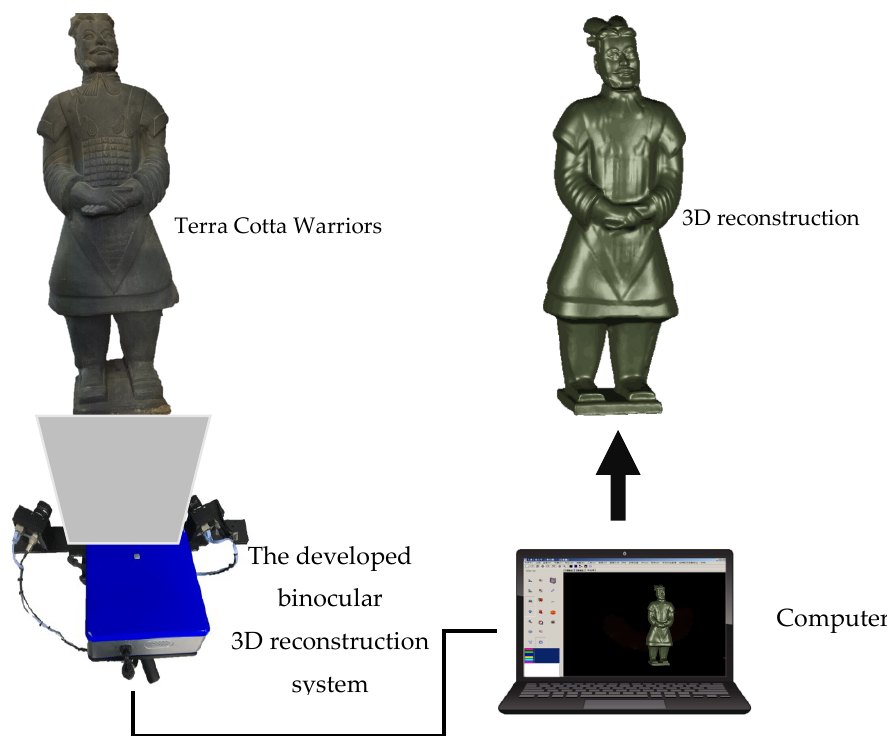
Figure 4. The binocular 3D reconstruction system developed in our Lab.